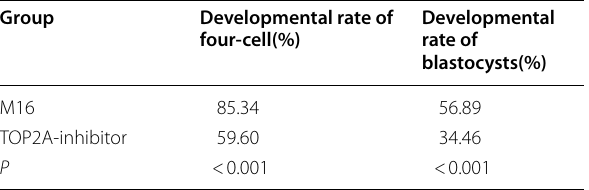
Table 2 Effect of TOP2A-inhibitor on mouse preimplantation embryo development